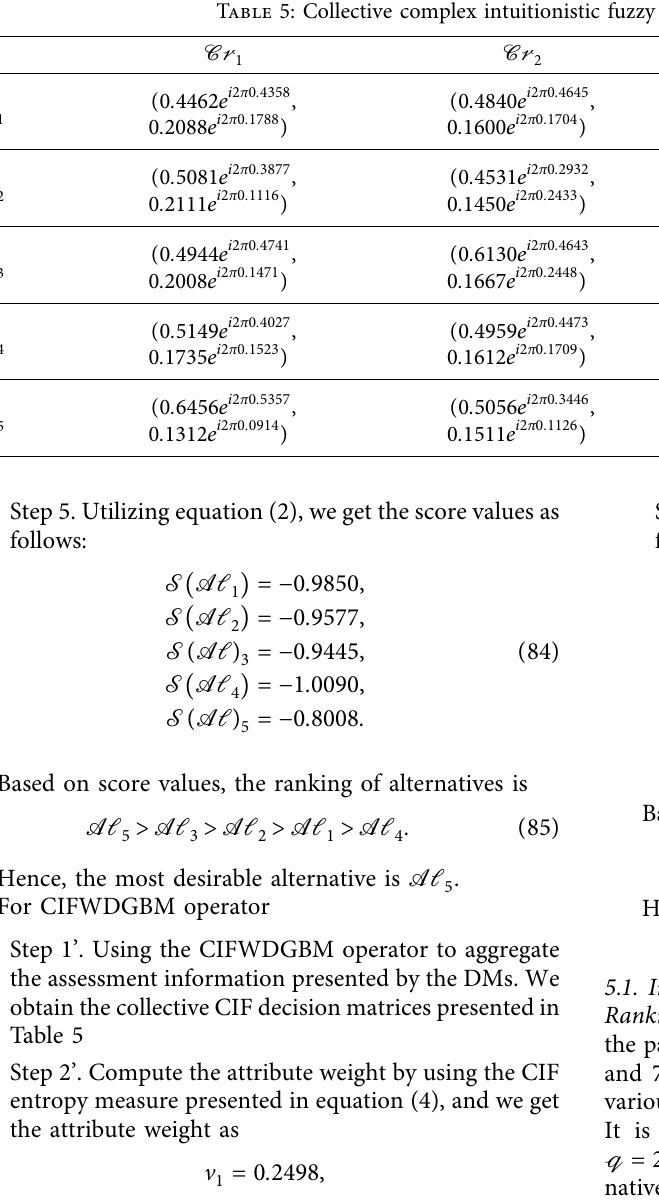
Table 5: Collective complex intuitionistic fuzzy decision matrix Ὤ � [ L